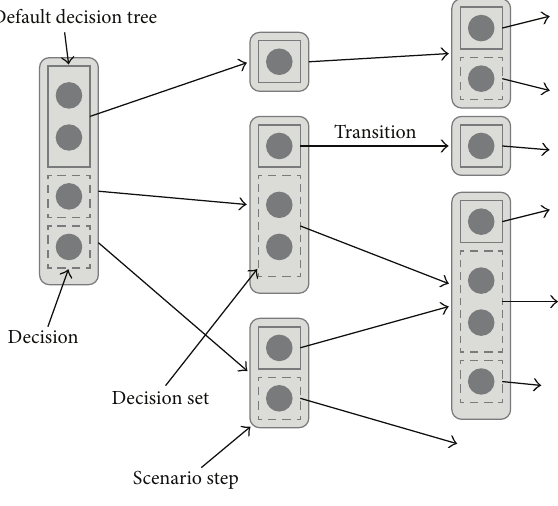
Figure 11: Decision tree.